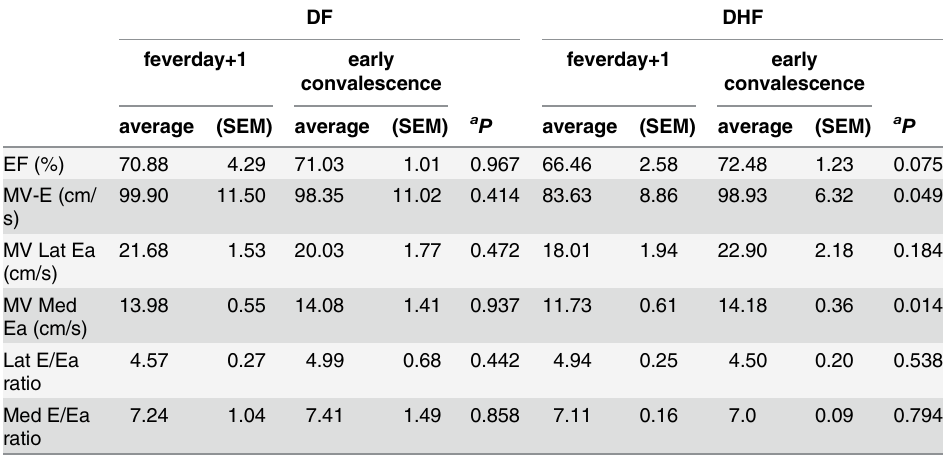
Table 5. Comparison between cardiac function at fever day +1 and early